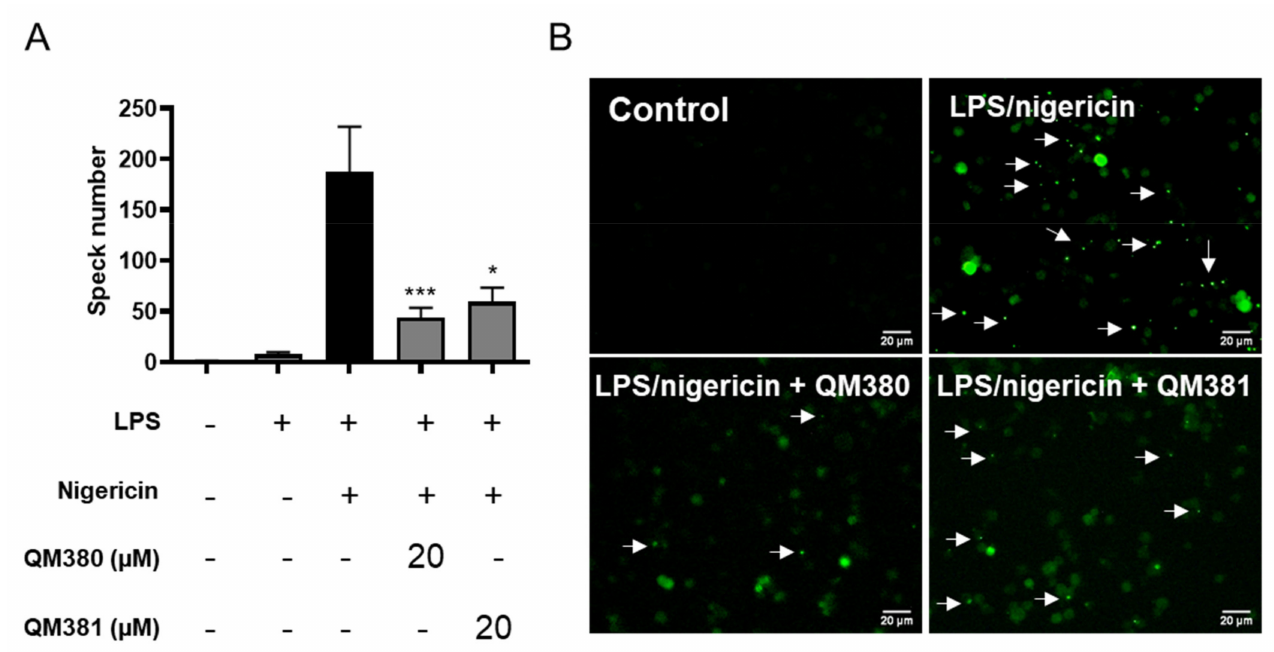
Figure 4. QM380 and QM381 inhibit ASC speck formation: ( A ) Percentage of ASC specks measured in THP-1-ASC-GFP cells treated with QM380 and QM381 (20 µ M) and stimulated with LPS (100 ng/mL) and nigericin (10 µ M). ( B ) Live-cell imaging of THP-1-ASC-GFP cells treated as indicated above. Scale bar corresponds to 20 µ m. Arrows point to ASC specks. Asterisks represent significant differences compared to the stimulated control (LPS/nigericin) as determined by a one-way ANOVA test with Tukey’s multiple post-test comparisons * p < 0.05; *** p < 0.001. All data are expressed as the mean ± SD of four independent